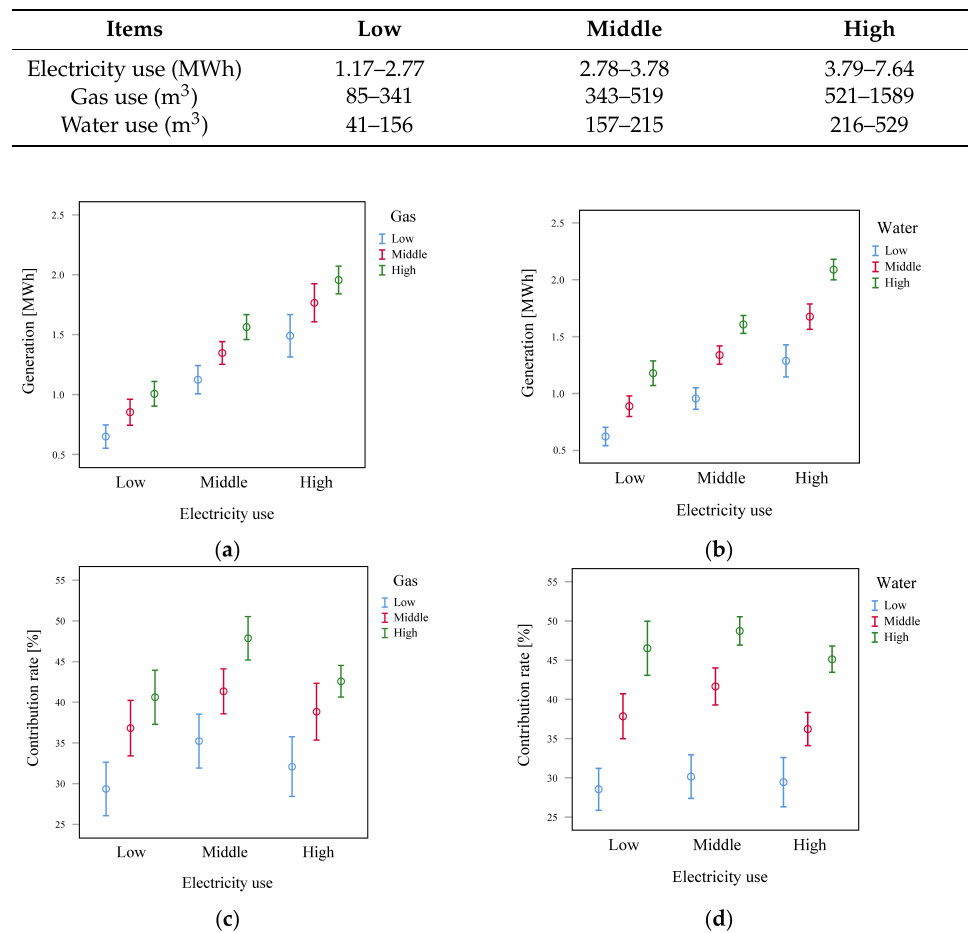
Figure 7. Relationship between the annual energy-saving effect of cogeneration system (CGS) and the annual electricity use by three levels of gas use (except for CGS) or water use (n = 304): ( a ) generation by gas use; ( b ) generation by water use; ( c ) contribution rate by gas use; ( d ) contribution rate by water